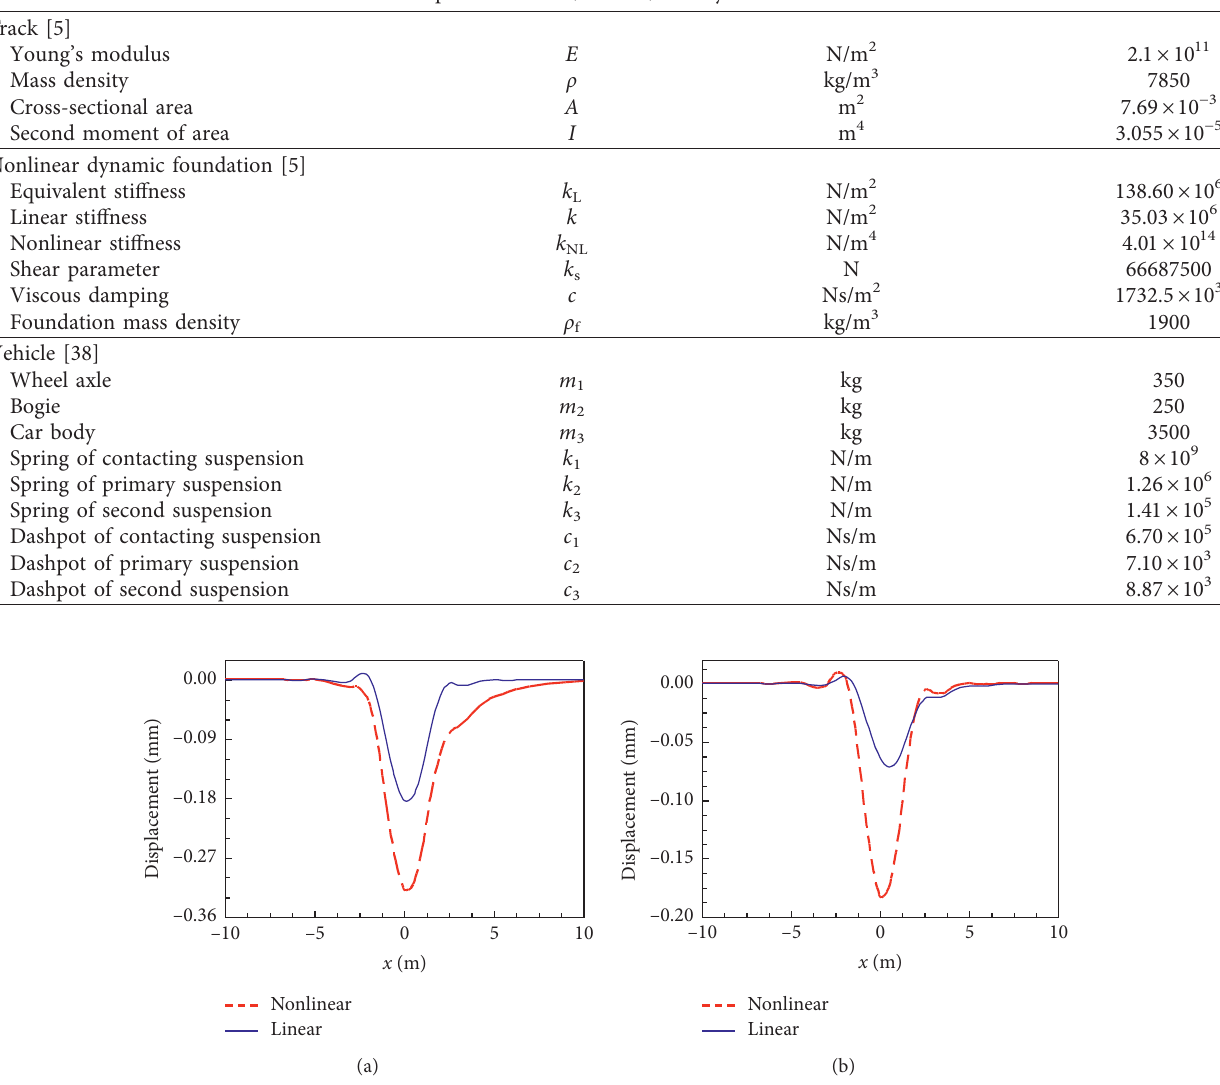
Figure 5: The time history of dynamic response of the beam: (a) nonlinear foundation and (b) linear foundation. Table 1: Properties of track, vehicle, and dynamic foundation.